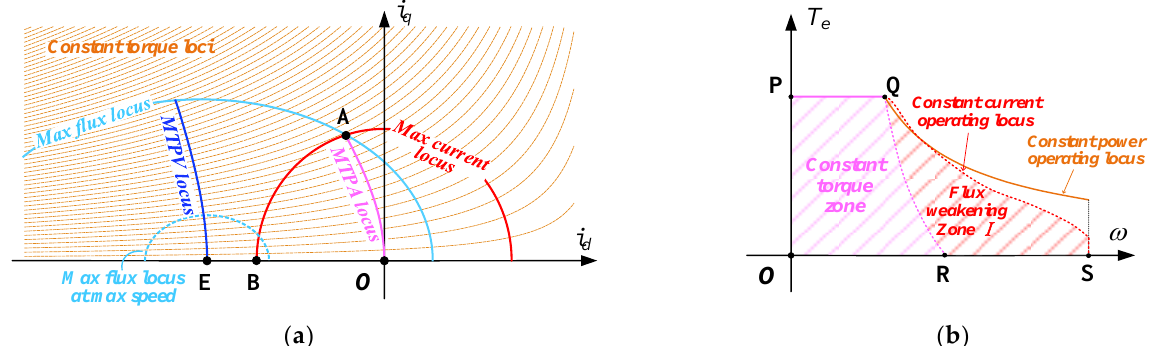
Figure 2. Mapping status when feature points are outside the current circle: ( a ) d-q axis current plane; ( b ) torque-speed plane.